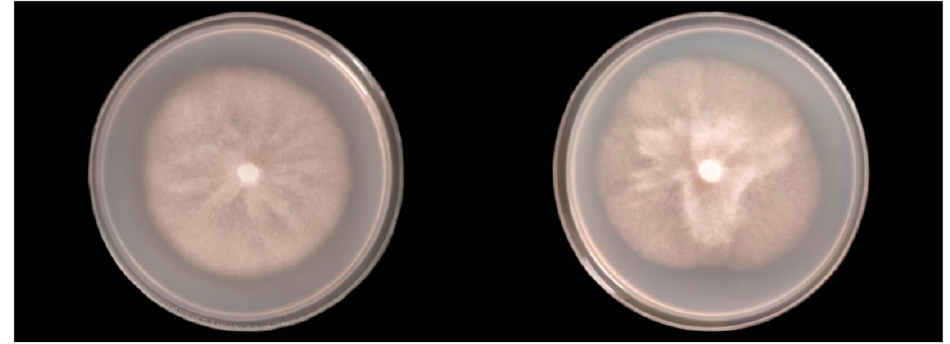
Figure 5. Colony morphology of Phytophthora podocarpi , NZFS 3642 (ICMP 24118), grown on carrot agar at 17 °C for 28 days, ( Left ) In darkness; ( Right ) Under continuous light.